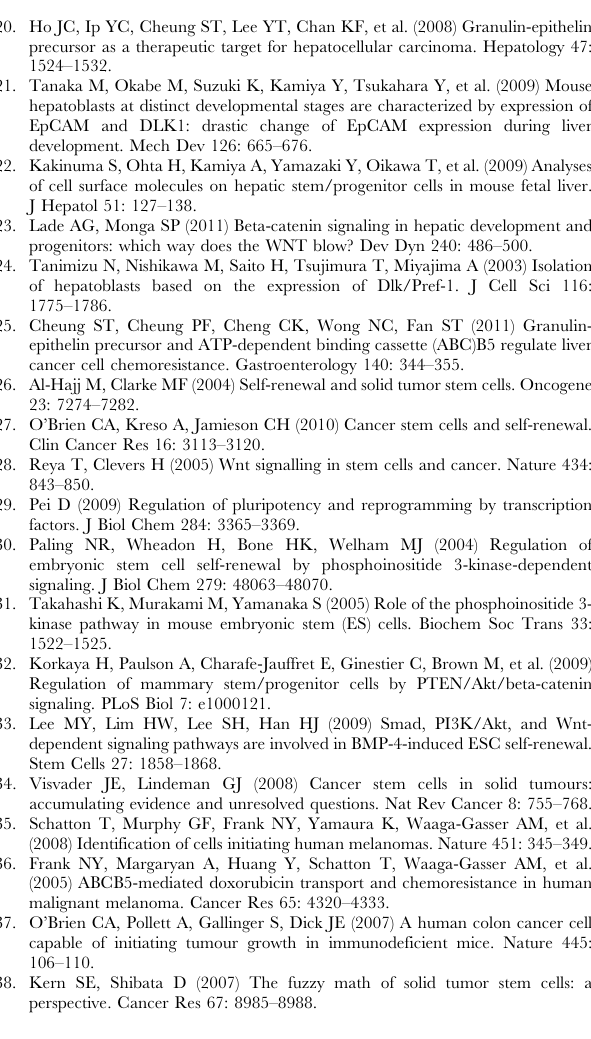
equal loading of protein. Figure S3 Phenotypic characterization of GEP-express- ing cells in liver cancer cell line Hep3B. Flow cytometric analyzes showing co-expression of GEP with stem cell markers b - catenin, Oct4, Nanog, Sox2, CD133, EpCAM and ABCB5. Protein expression of GEP, b -catenin, Oct4, Nanog, Sox2 and ABCB5 was measured by intracellular staining, while that of CD133 and EpCAM was assessed by surface staining. Cells co- expressing the respective markers were shown in the upper right quadrant of each scatter plot. Data are expressed as mean percentage of cells 6 SD. Figure S4 Phenotypic characterization of GEP-express- ing cells in liver cancer cell line Huh7. Flow cytometric analyzes showing co-expression of GEP with stem cell markers b - catenin, Oct4, Nanog, Sox2, CD133, EpCAM and ABCB5. Protein expression of GEP, b -catenin, Oct4, Nanog, Sox2 and